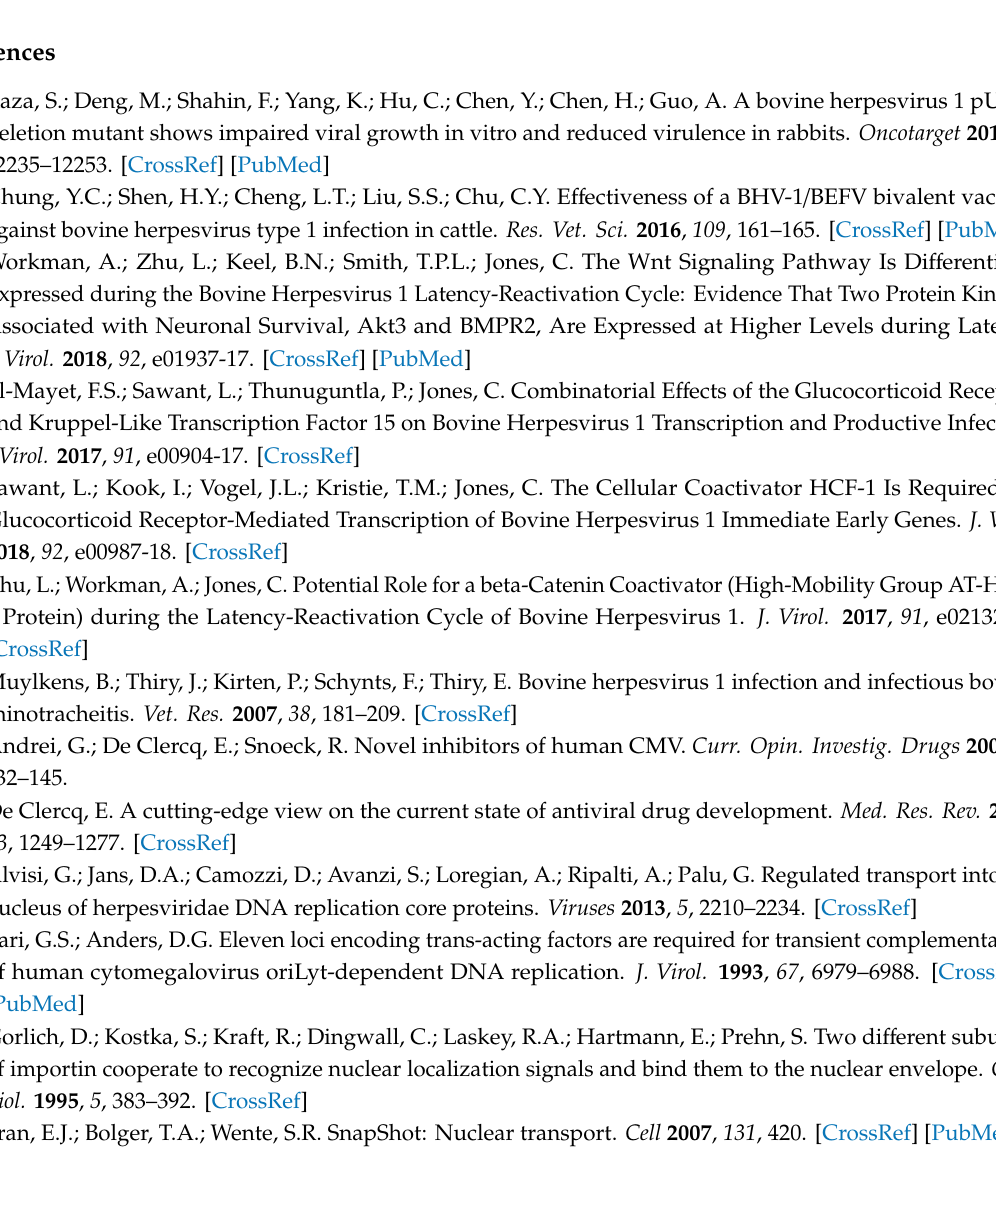
Figure S1: Antiviral activity of Ivermectin against